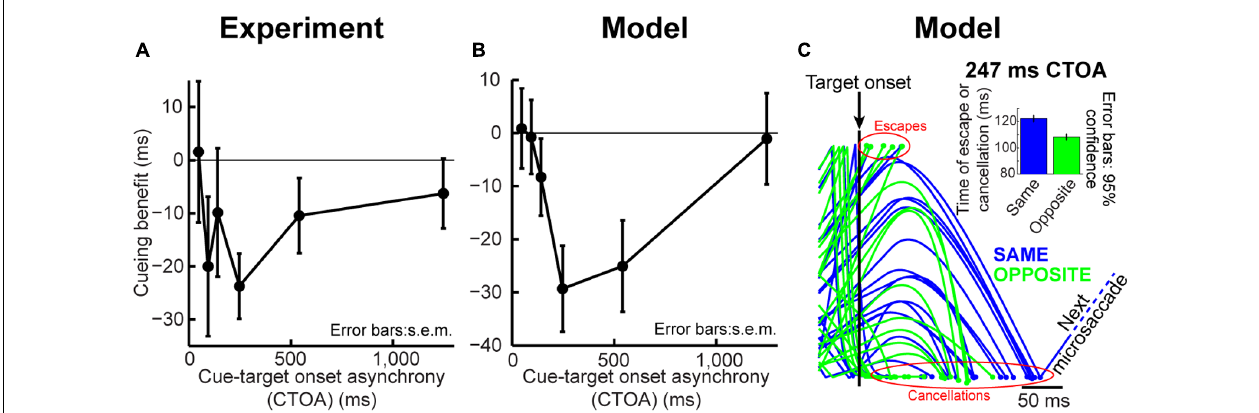
FIGURE 5 | Dissecting performance dynamics in the cueing task. (A) Cueing benefit (as defined in Figure 3 ) computed for the first microsaccade RT after target onset. Like larger saccades, these “escapes” exhibited similar dynamics after cue onset, with maximal IOR-like behavior at ∼ 247 ms. Error bars denote SEM. (B) Similar analysis for our model data. We ran the model microsaccade generator for each CTOA for 2,000 trials, and we measured first microsaccade RT. The first microsaccade exhibited cueing dynamics. Attentional capture at the shortest CTOA was less obvious (even in the real data) because of low microsaccade frequency at this CTOA (see Figure 6 ). Thus, even when analyzing the distribution of microsaccades occurring after target onset, their RT’s exhibited dynamics similar to Figure 3 . (C) Twenty randomly chosen model trials from the “same” (blue) and “opposite” (green) conditions showing target influence at 247 ms CTOA. Most microsaccades were canceled by target onset, as expected (slowing of accumulator processes toward zero). However, because most microsaccades in the “opposite” condition were toward the target ( Figures 4C,F ), both the cancelation and escape mechanisms showed different temporal dynamics from the “same” condition, in which most microsaccades were opposite the target. The inset shows the combined latency of all canceled and escape time points at this CTOA, showing IOR (i.e., opposite faster than same). Inset error bars denote 95% confidence intervals.